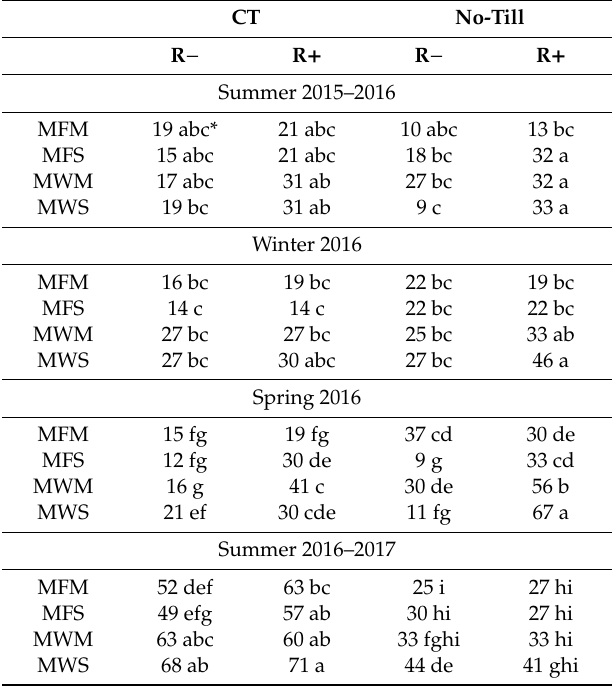
Table 5. Tillage × crop rotation × residue management e ff ects on earthworm total density (counts m − 2 ) research farm.